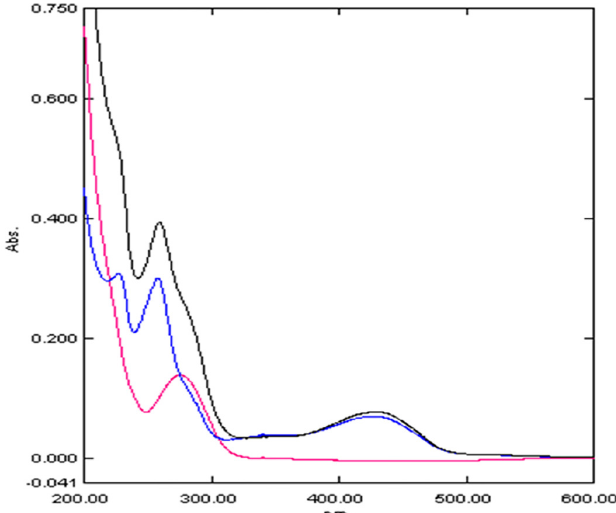
FIGURE 2 - Zero order spectrum of DC (blue), DS (red) and mixture of DC and DS